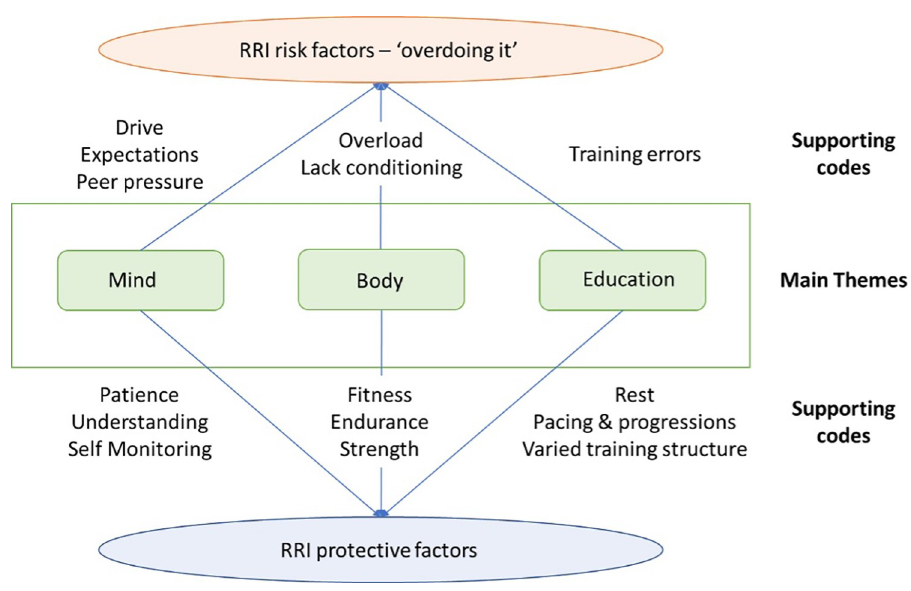
Fig 1. The internal locus of